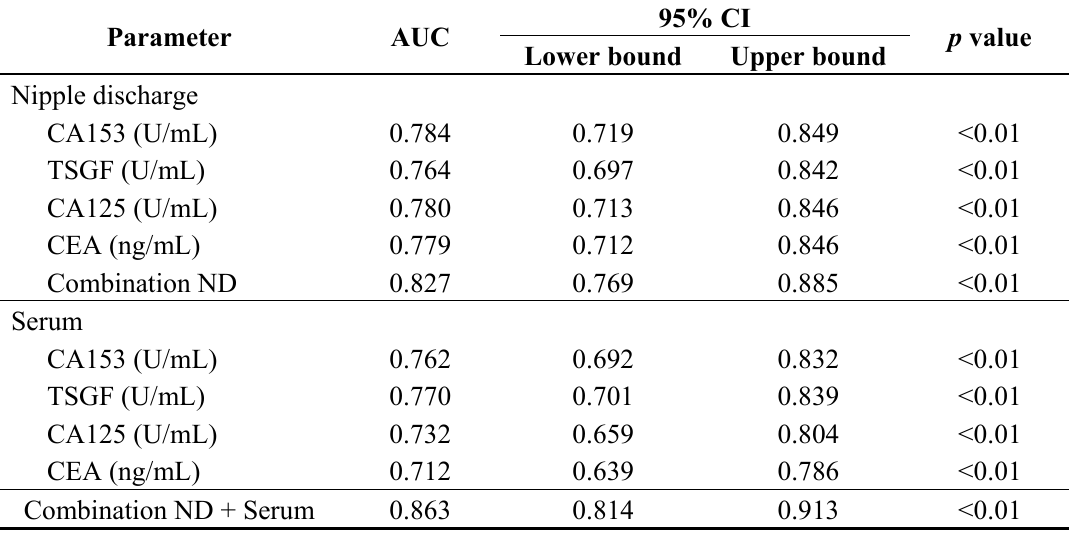
Table 3. ROC curve analysis of clinicopathological